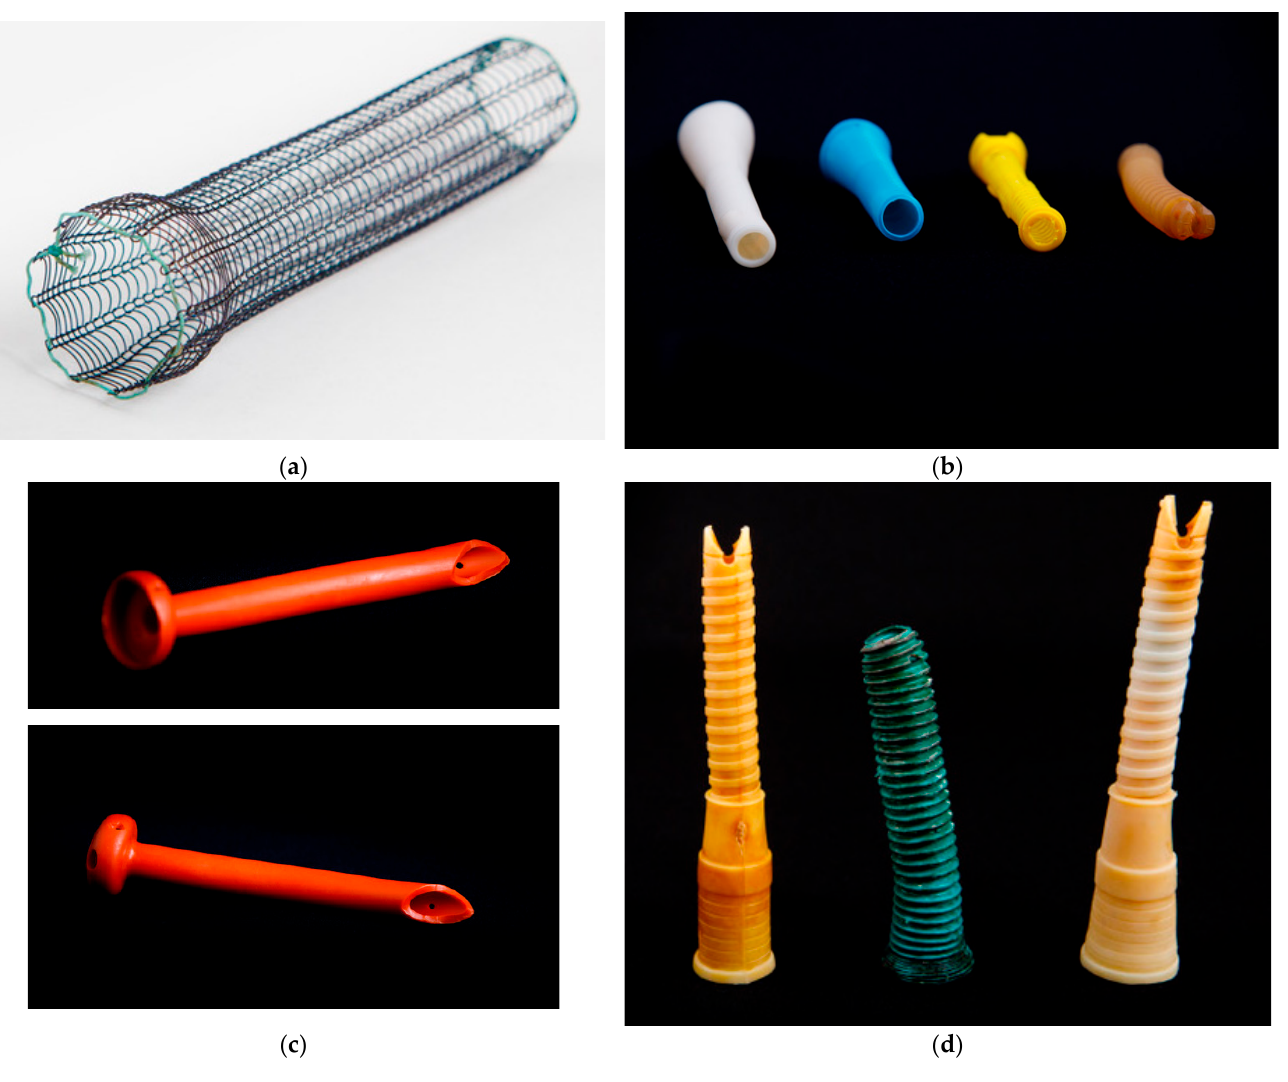
Figure 3. ( a ) Self-expanding metal stent. ( b ) Prosthesis with successive diameters. Stents used for esophageal stenting with laparogastroscopy—the original method used since 1996. ( c ) Pezzer prepared at funnel level and dimensionally adapted (3–18 mm in diameter) according to possibilities, 10–15 cm in length. ( d ) Migrated and extracted stents.